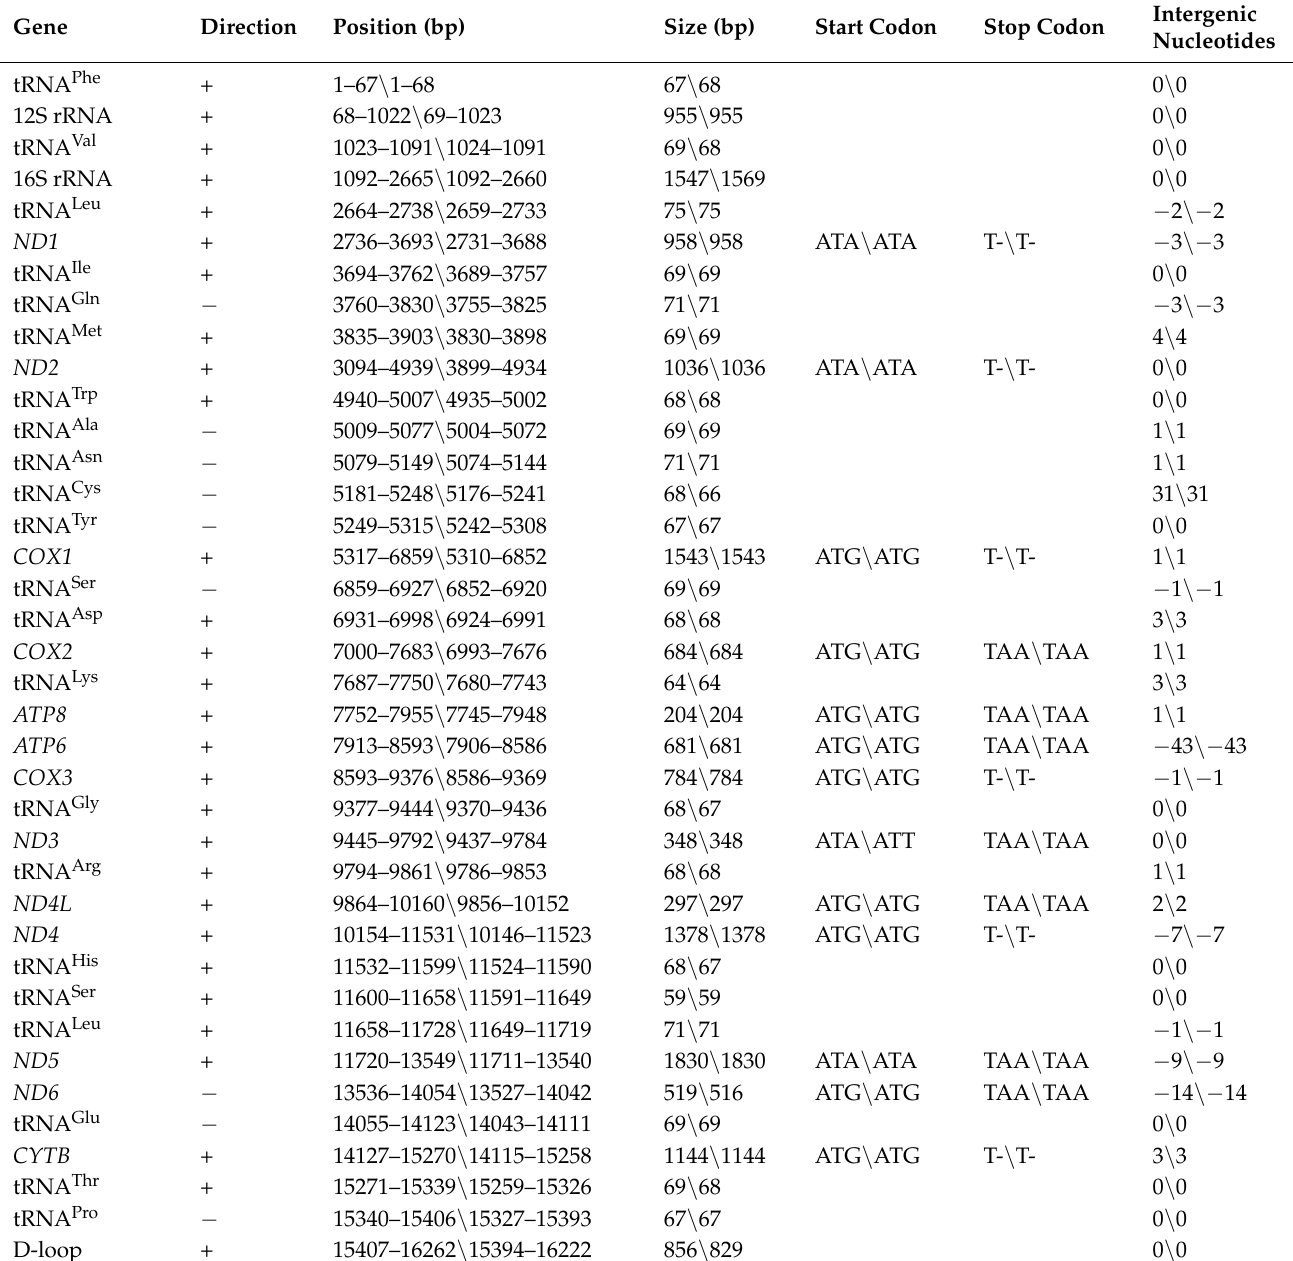
Table 2. Mitochondrial composition of Apodemus agrarius ningpoensis (left) and Apodemus draco draco (right).